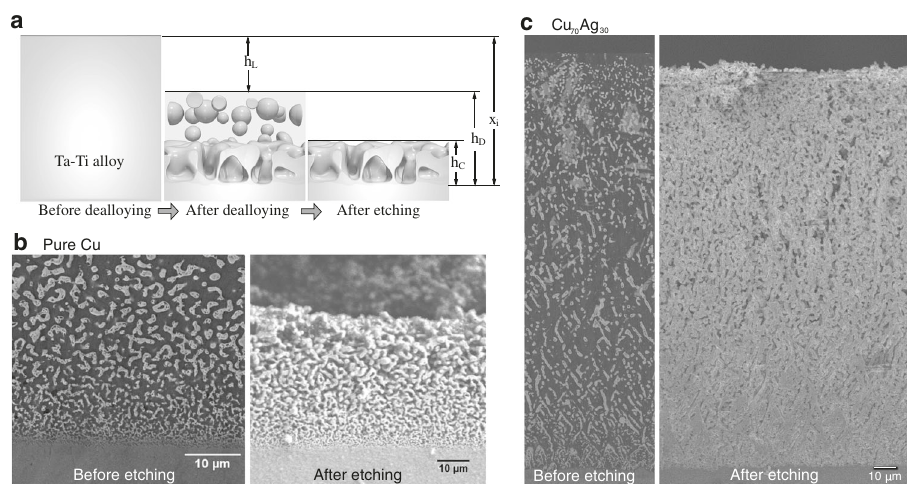
Fig. 4 Experimental dealloyed structures. a A schematic diagram of the morphological evolution during the dealloying process and the de fi nition of the geometric parameters: the thickness of Ta leak h L , the thickness of the dealloyed structure h D , and the thickness of the connected structure h C . ( b ), ( c ) Experimental validation of phase- fi eld simulations results comparing SEM sections and 3D etched morphologies for Ta 15 Ti 85 alloys dealloyed by pure Cu ( b ) and Cu 70 Ag 30 melts yielding a topologically connected structure with uniform ligament size ( c ); scale bars 10 μ m.